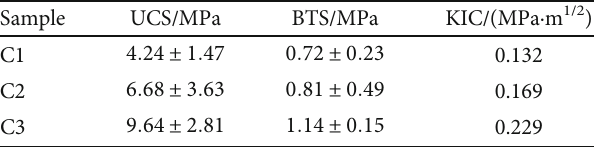
Table 2: Mechanical properties of the samples.